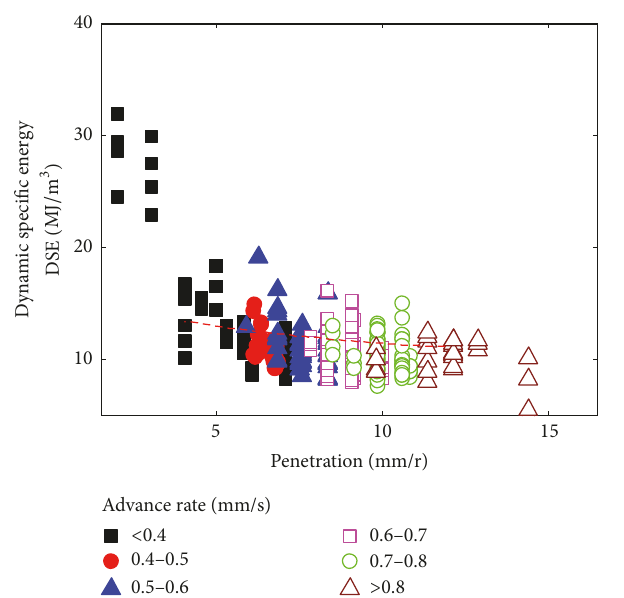
Figure 15: Correlation of DSE and operational parameters obtained from on-site measurement (dashed red line is the fitted curve of simulation DSE in soft rock